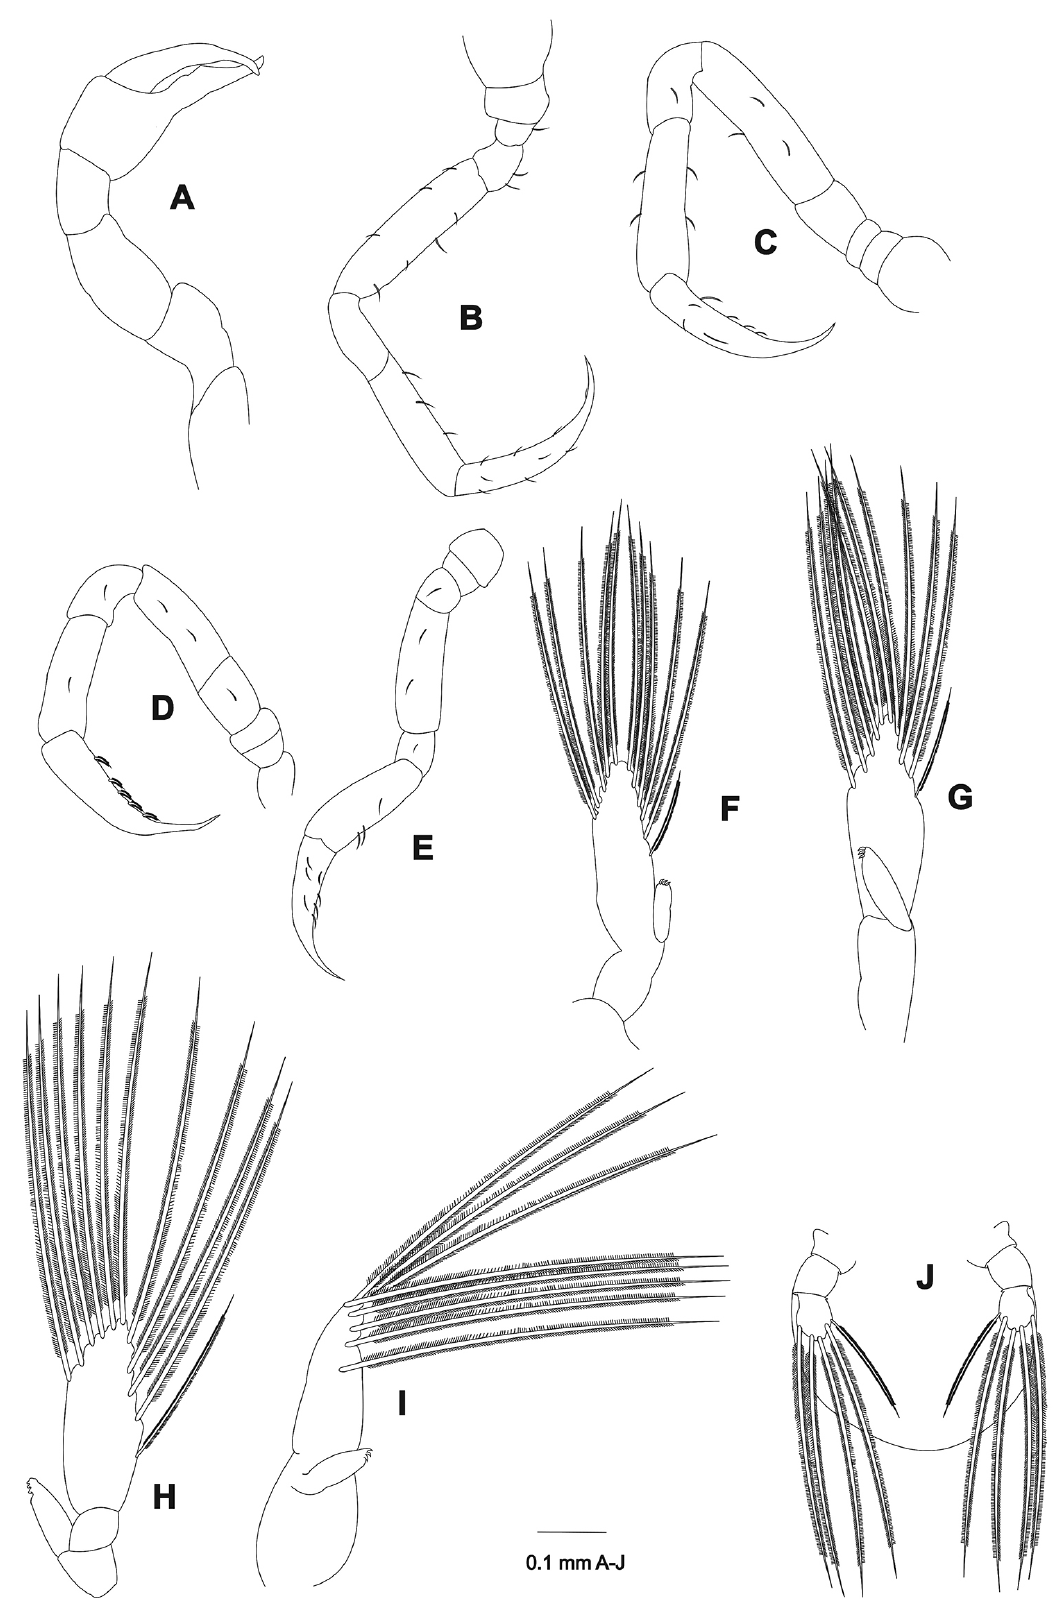
Figure 7. Libinia rhomboidea megalopa. ( A ) Cheliped; ( B ) pereiopod 2; ( C ) pereiopod 3;, ( D ) pereiopod 4; ( E ) pereiopod 5; ( F ) pleopod 1; ( G ) pleopod 2; ( H ) pleopod 3; ( I ) pleopod 4; ( J ) uropod and